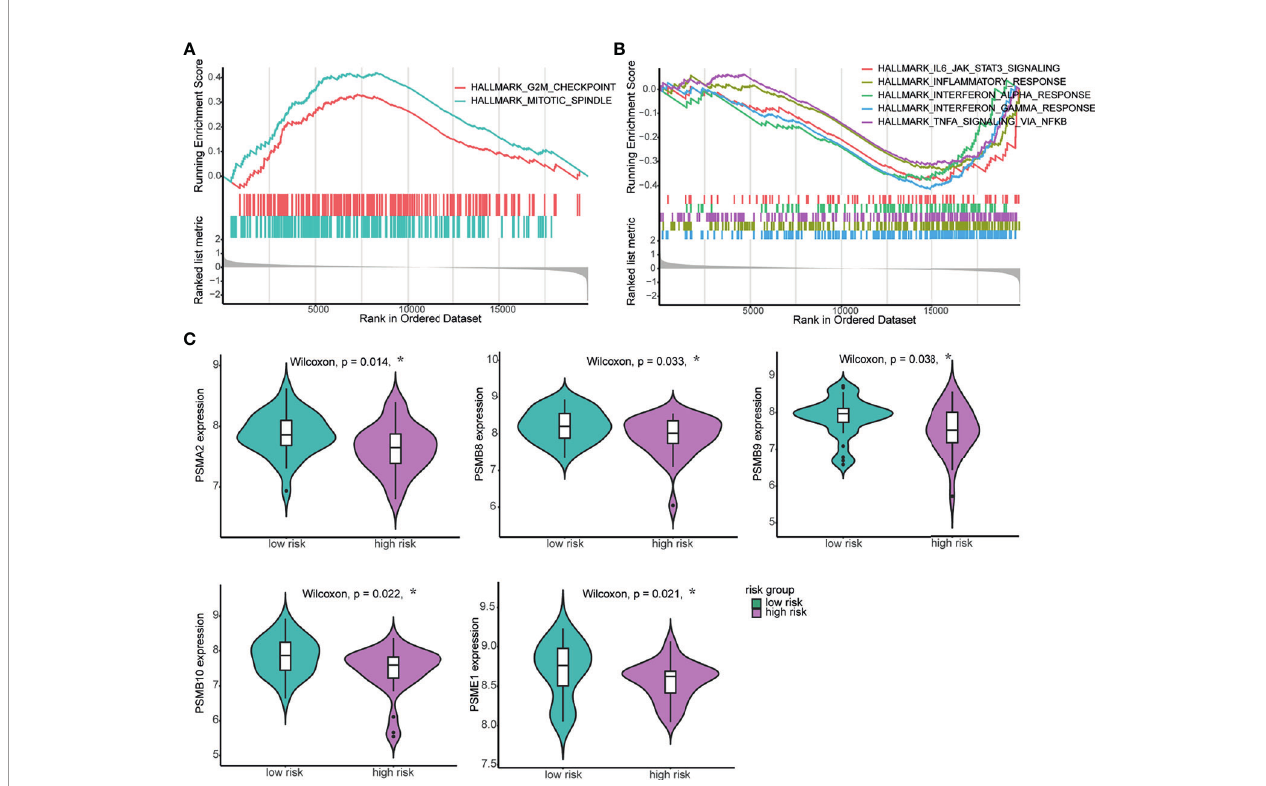
FIGURE 4 | Biological relevance of the 4-mRNA signature in NPC. (A, B) GSEA of biological pathways correlated with the 4-mRNA signature. (A) The proliferation- related hallmark gene sets “ mitotic spindle ” and “ G2/M checkpoint ” were enriched. (B) The immune response-related hallmark gene sets “ IL-6-JAK-STATS signaling ” , “ in fl ammatory response ” , “ interferon alpha response ” , “ interferon gamma response ” and “ TNF signaling via NF- ĸ B ” were enriched. (C) The expression levels of genes related to the IFN- g response between the high-risk and low-risk groups. *p <